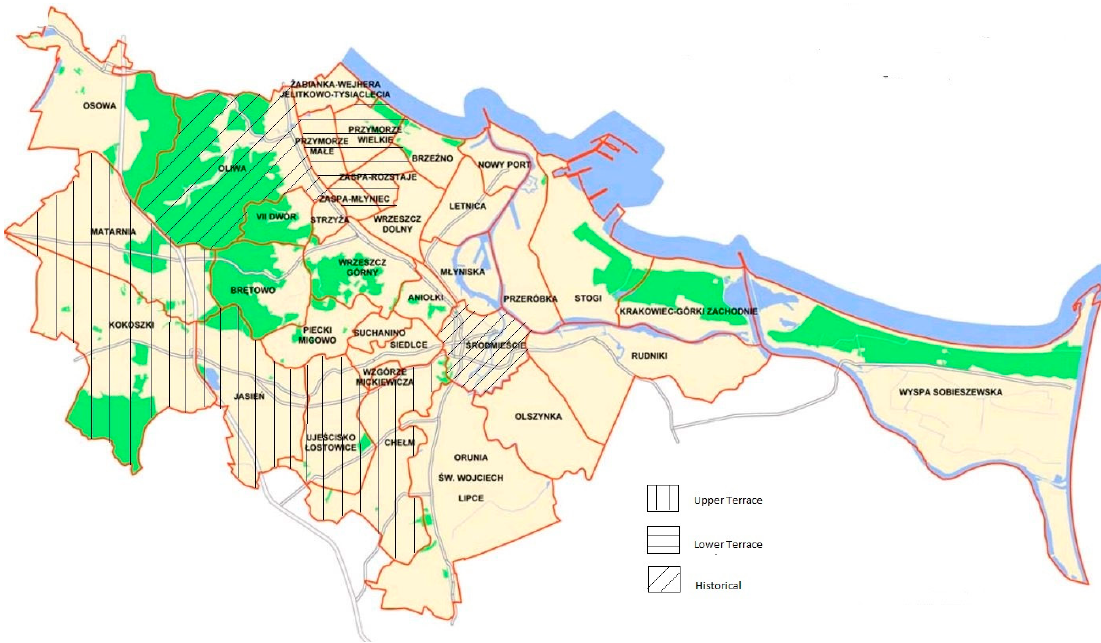
Figure 1. Map of the studied neighbourhoods in Gda ń sk.